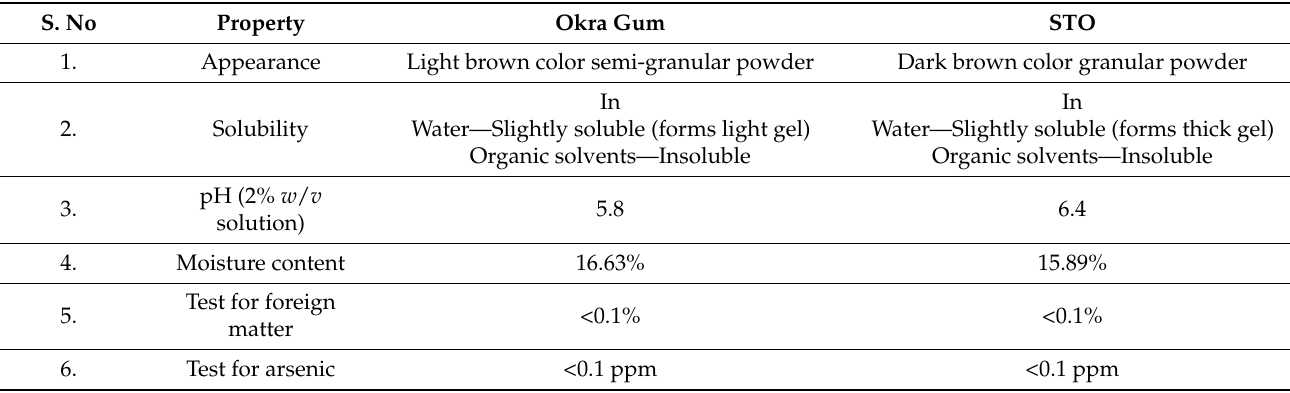
Table 1. Comparison of physicochemical properties of okra gum and